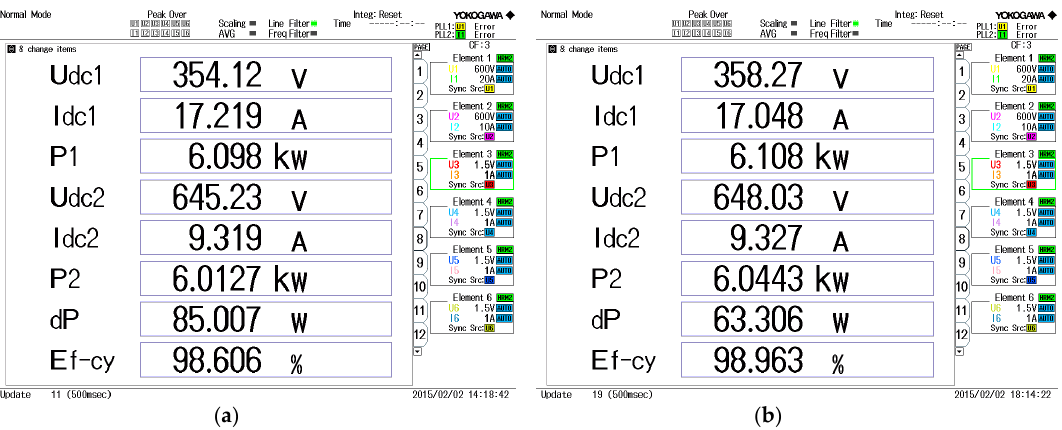
Figure 12. Power losses ( Δ P) of the converter obtained at different output power P 2 and gate resistance Figure 12. Power losses ( ∆ P) of the converter obtained at different output power P 2 and gate resistance values ( R G1 – R G4 = 33 Ω ; = 20 Ω ; = 10 Ω ) and type of input inductors ( L 1a – L 4a ; L 1b – L 4b ); f s = 125 kHz, D = 0.45. values ( R G1 – R G4 = 33 Ω ; = 20 Ω ; = 10 Ω ) and type of input inductors ( L 1a – L 4a ; L 1b – L 4b ); f s = 125 kHz, D = 0.45.